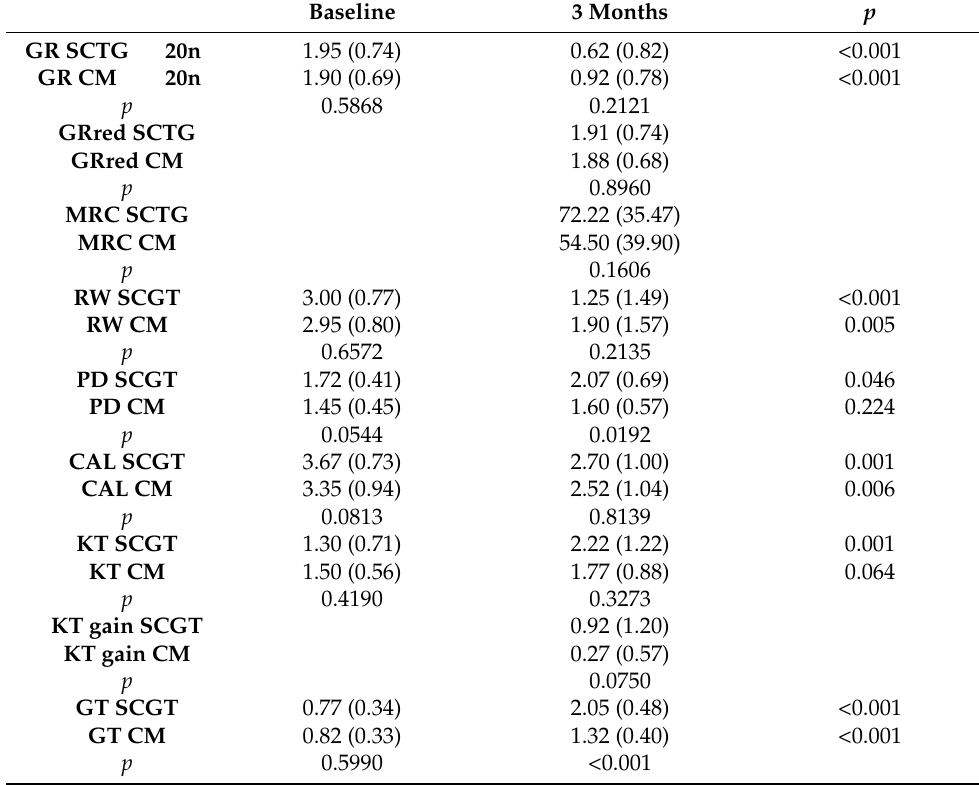
Table 2. Clinical parameters over 3-month observation.